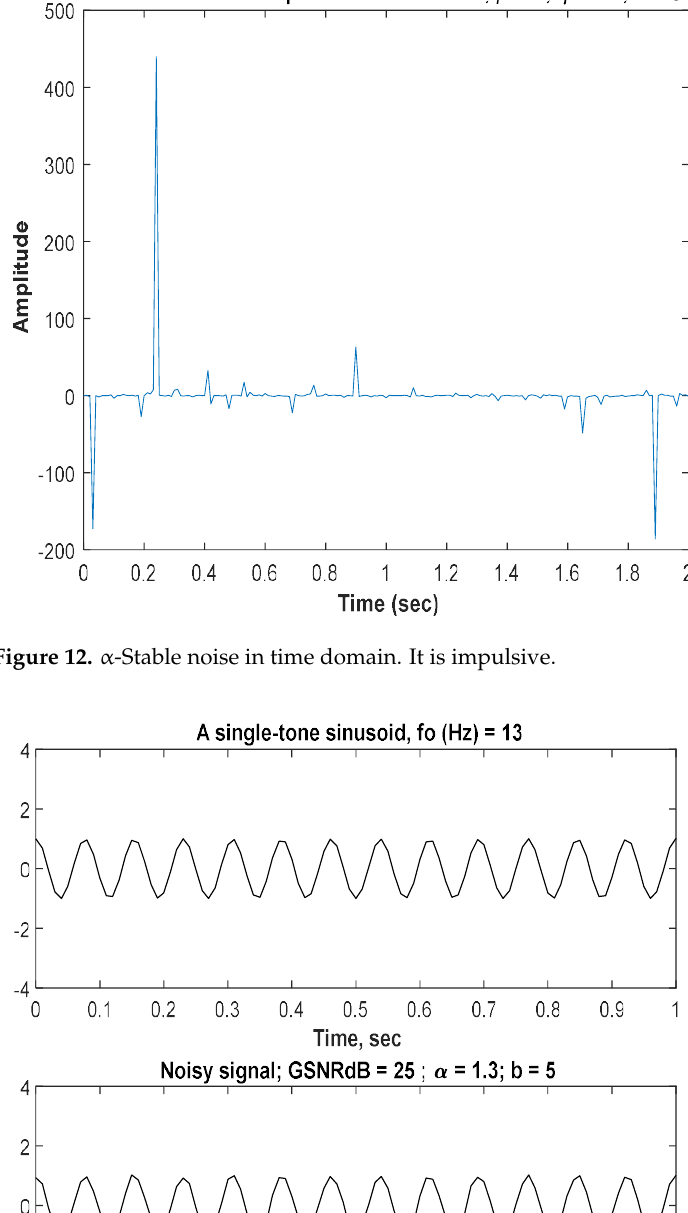
Figure 14. FE of noisy single tone signals by DNN.